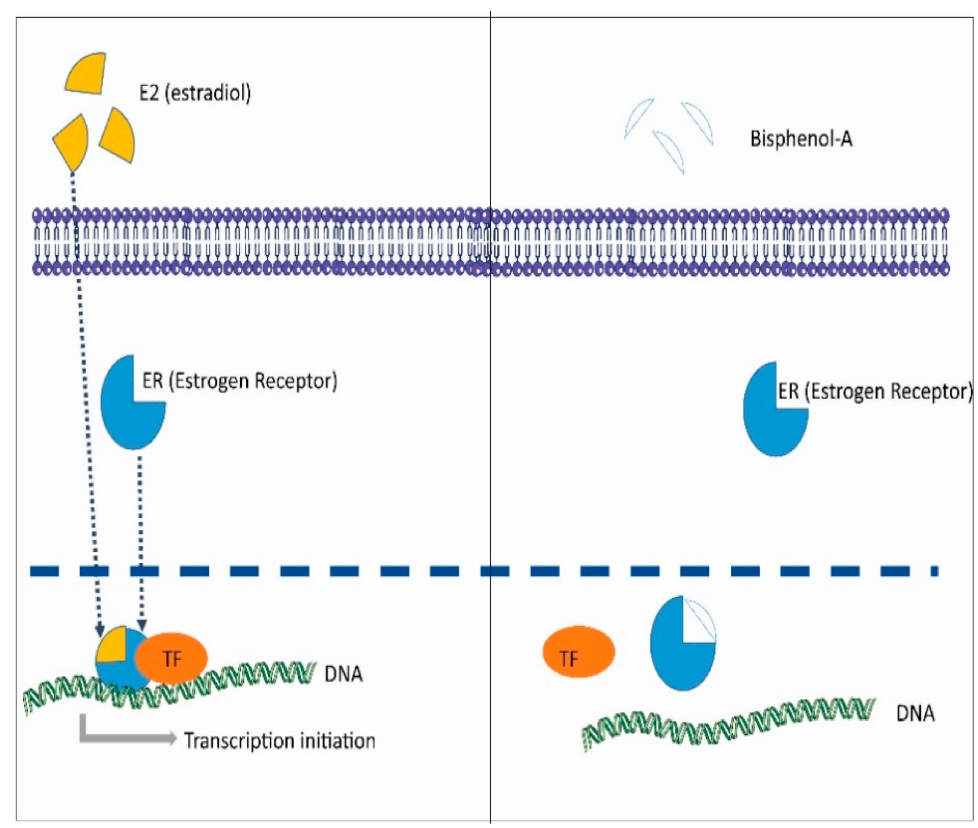
Figure 5. Possible mechanism adapted by bisphenol A (BPA) to cause antagonistic effects to disrupt normal signaling of estradiol via estrogen